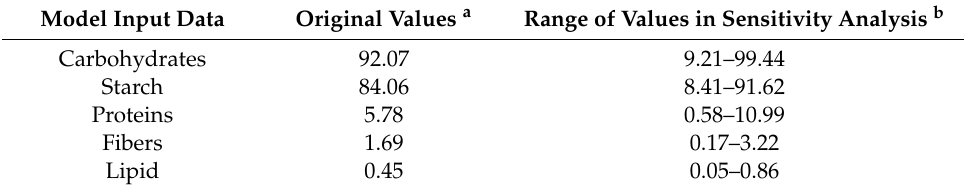
Table 2. Details of biomass function used for the rMeCBM-KU50 model and sensitivity